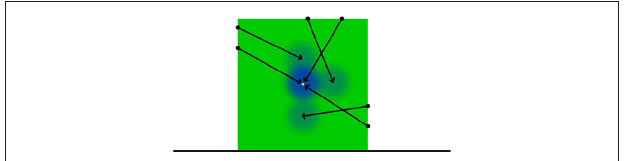
FIGURE 4 | Illustration of the position model application process. The ground truth position of the object demarked by green is indicated with a yellow point. The query density kernels are represented here in blue. These kernels form a PDF within SE (3) space over the object’s position. As such, the kernels can be supplied to an simulated annealing based optimiser in order to estimate the position of the object. FIGURE 5 | An example of the variety of objects that a given model can be